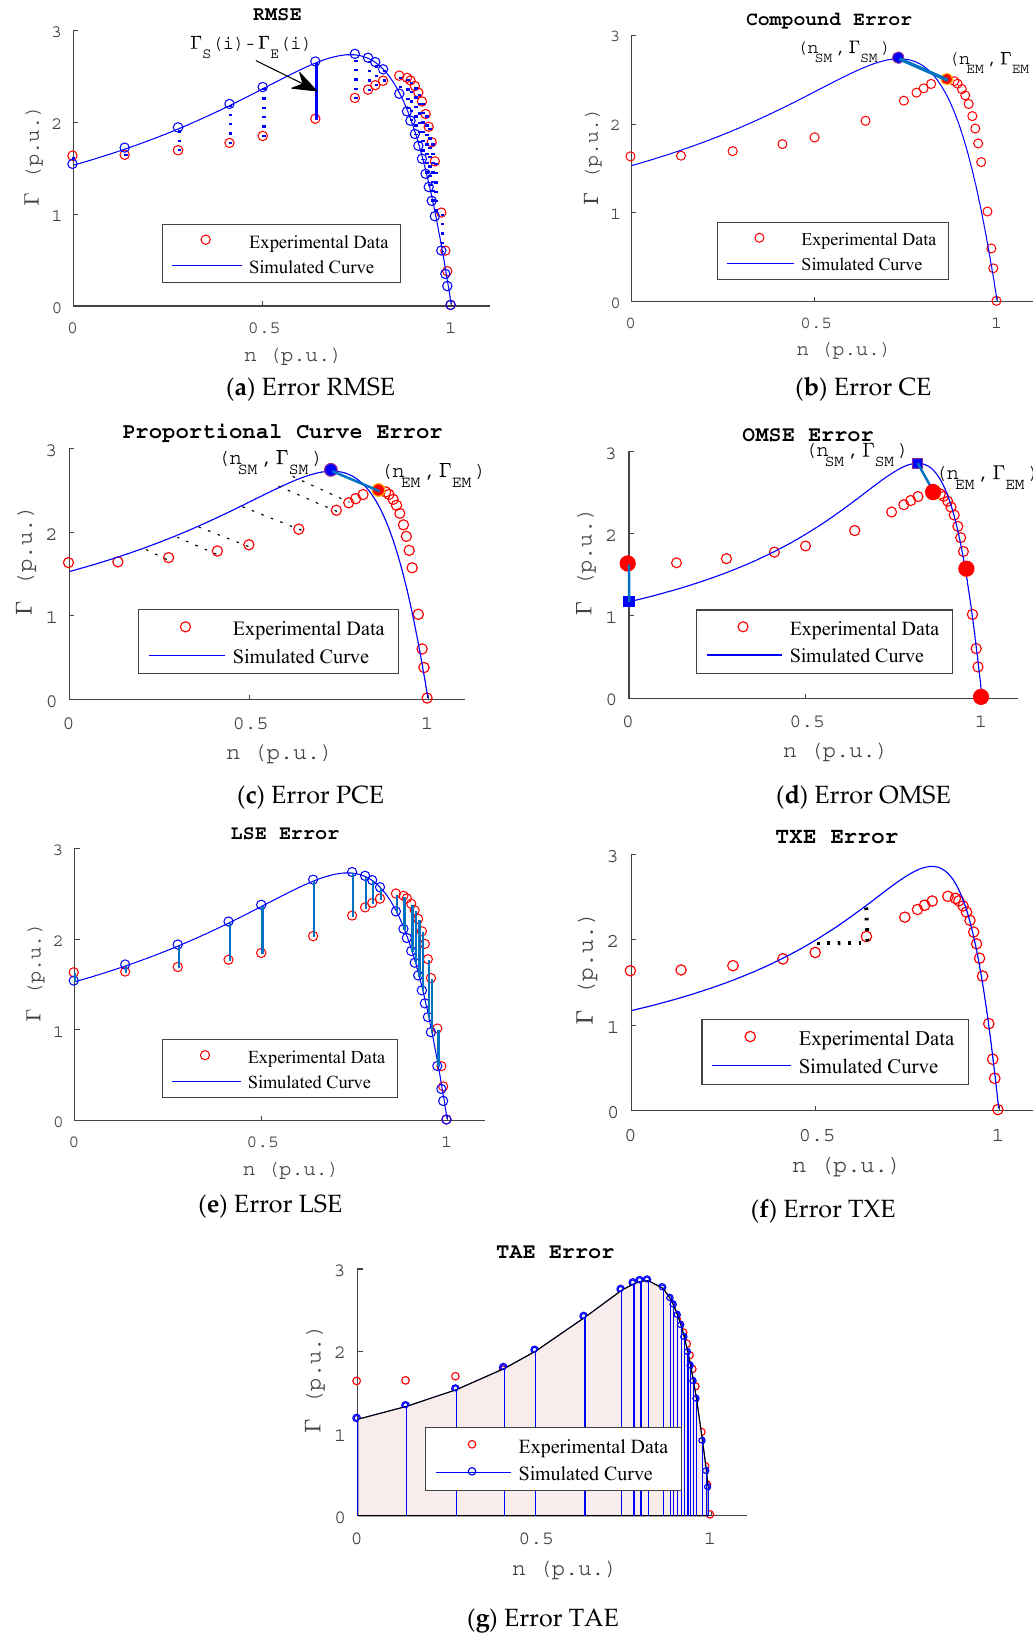
Figure 5. Error functions.